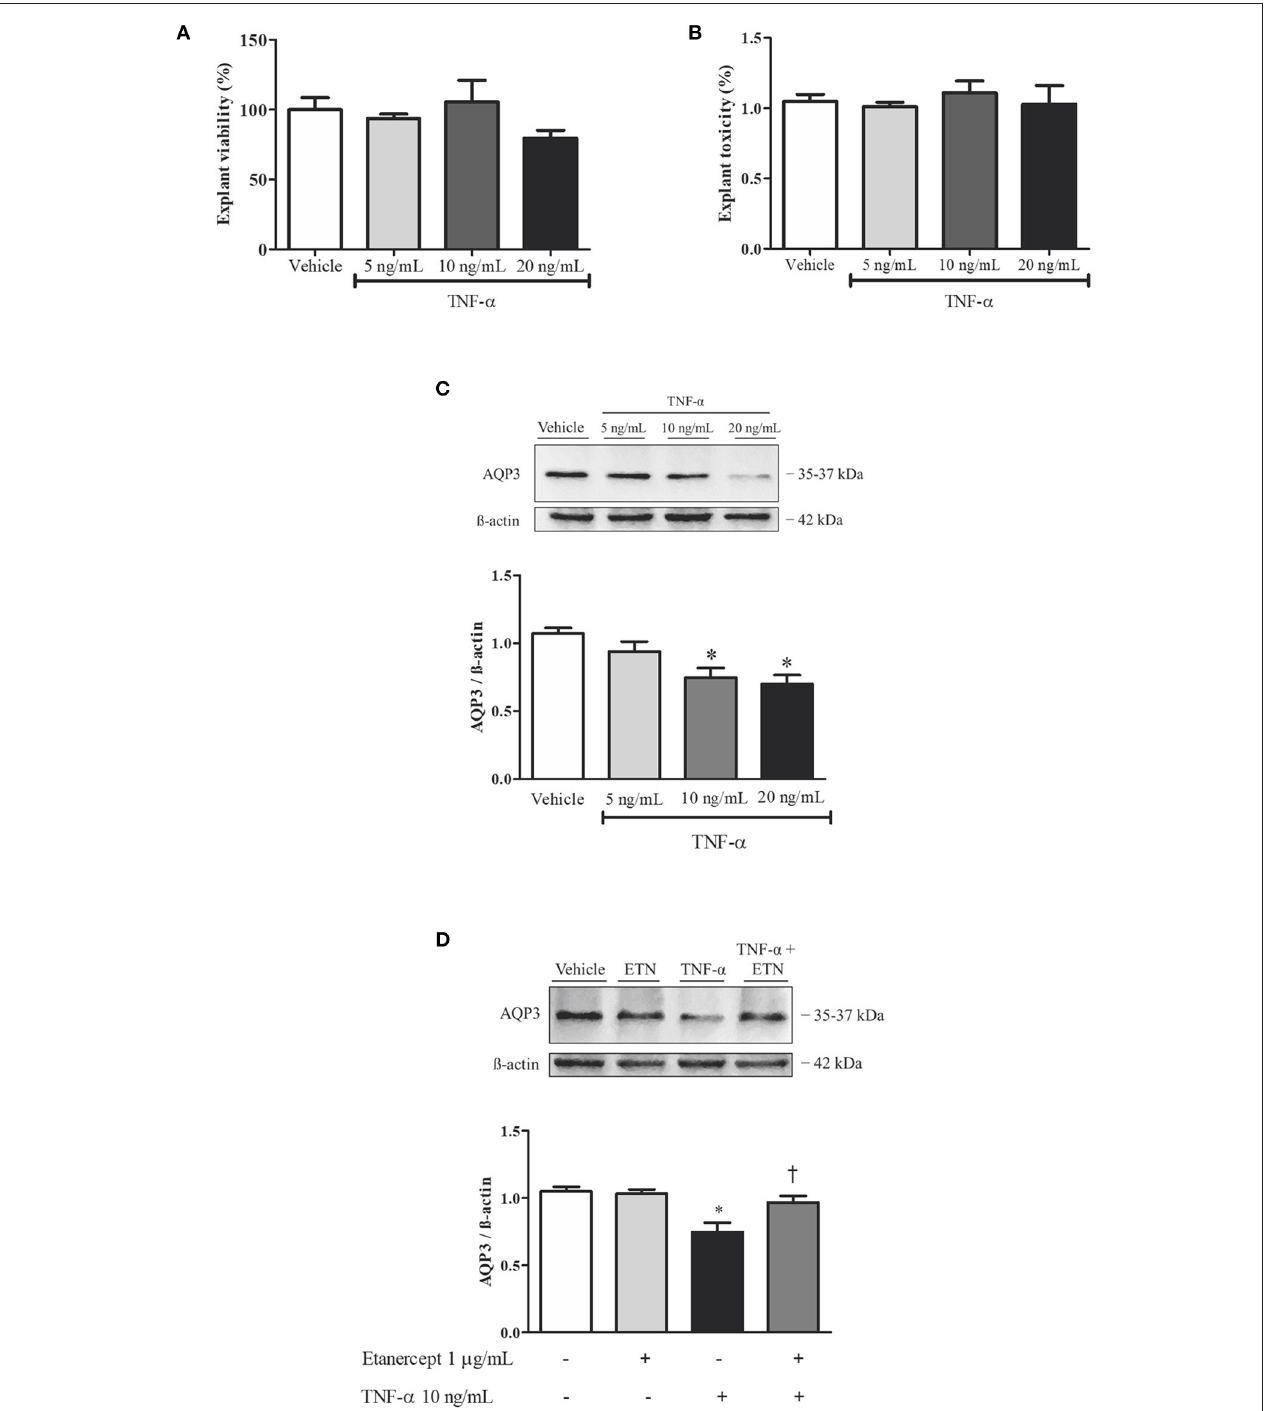
FIGURE 3 | Tumor necrosis factor-alpha (TNF- α ) incubation reduces aquaporin 3 (AQP3) expression in normal human placenta explants, and simultaneous incubation with TNF- α and etanercept (ETN) retrieves AQP3 expression. (A,B) Bar graphs showing explant viability and toxicity, respectively; n = 3. (C) Upper representative picture of Western blot membrane with the respective AQP3 molecular weight. Bar graphs showing the AQP3 expression upon incubation with vehicle ( n = 7), 5ng/ml TNF- α ( n = 6), 10ng/ml TNF- α ( n = 6), and 20ng/ml TNF- α ( n = 7). (D) Bar graphs showing the AQP3 expression upon incubation with vehicle ( n = 7), 1 µ g/ml etanercept ( n = 6), 10ng/ml TNF- α ( n = 6), and simultaneous TNF- α and etanercept ( n = 6). Values are presented as means ± SEM, and data were analyzed by one-way ANOVA, followed by Tukey posttest. * p < 0.05 vs. vehicle; † p < 0.05 vs. 10ng/ml TNF- α incubation.